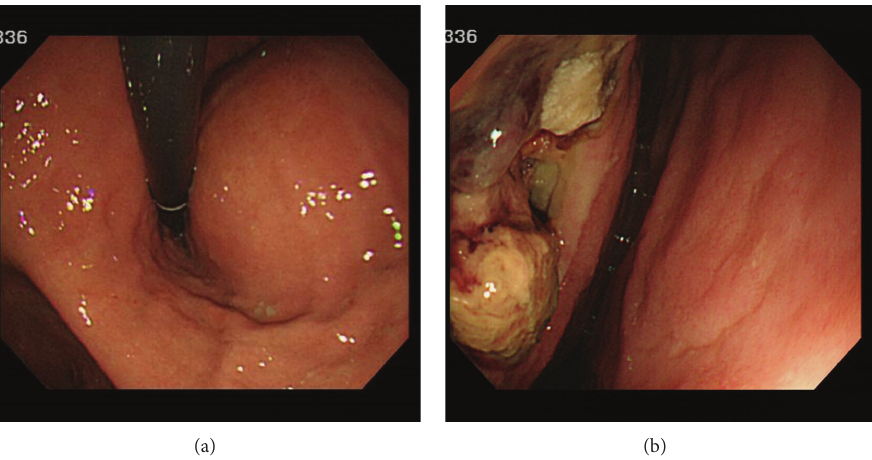
Figure 1: Upper GI endoscopy, showing a giant submucosal-like tumor in the stomach with oozing from an ulceration.